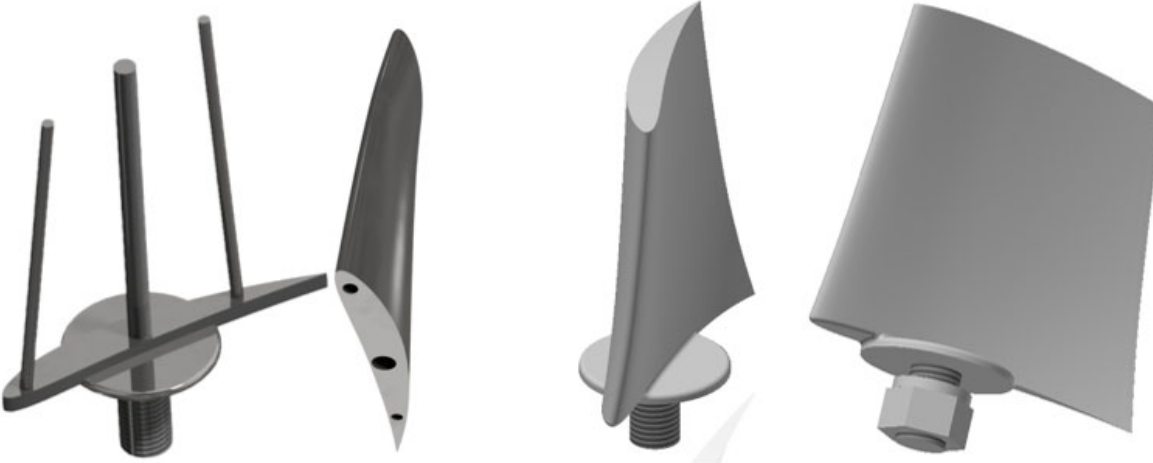
Figure 9. Metal base of the blade, 3D-printed blade and the complete model of the blade.